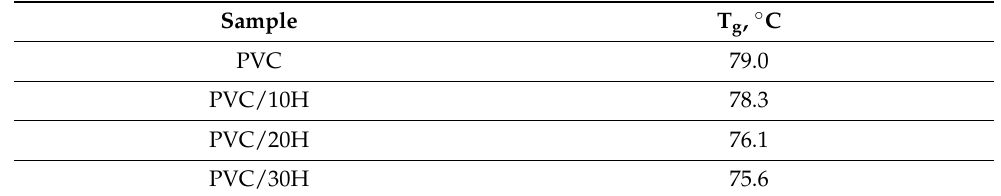
Figure 6. DSC thermograms of PVC and PVC composites. Table 5. Glass transition temperature of PVC and PVC-based composites. Table 5. Glass transition temperature of PVC and PVC-based